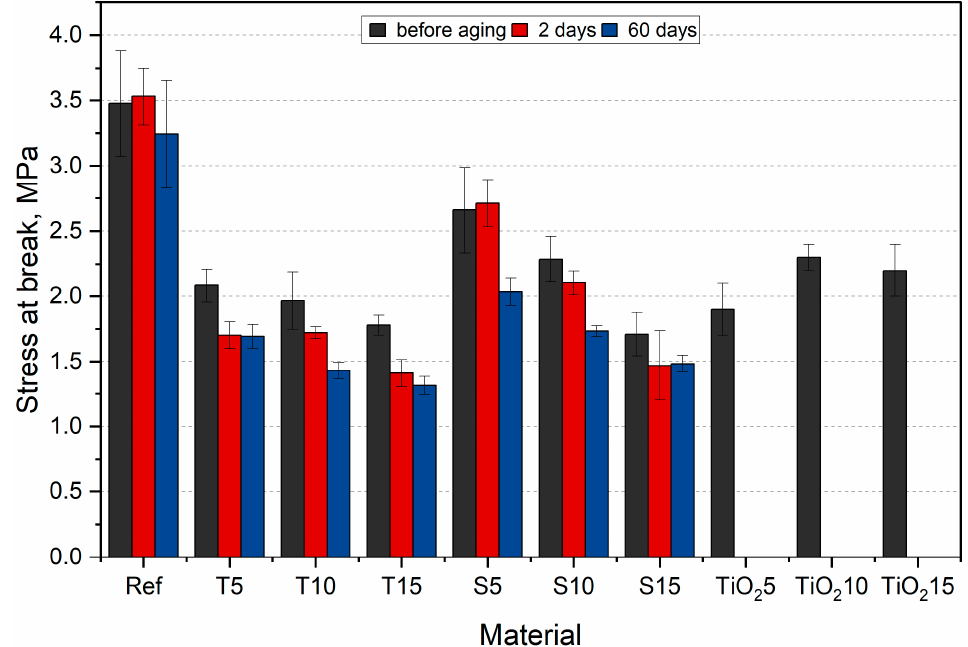
Figure 16. Stress at break results, along with reference data from [55]. After incorporating organic fillers, the smallest drop in stress at break value was ob- served for S5 (23%), while the biggest drop in value was observed for S15 (49%). The range for T5 to 48% for T15). Such large differences observed for composites with thyme result